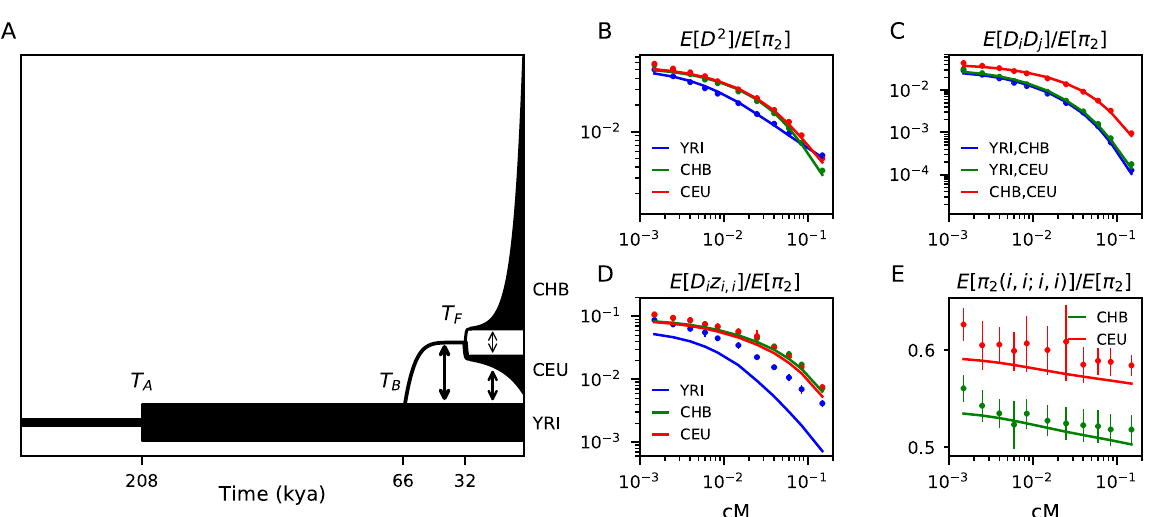
Fig 3. Standard out-of-Africa model underestimates LD among low frequency variants. (A) We fit the 13-parameter Gutenkunst et al . model to statistics in the two-locus, multi-population Hill-Robertson system. The remaining 35 statistics from the Hill-Robertson basis used in the fit are shown in Fig A7 in S1 Appendix, and residuals are shown in Fig A8 in S1 Appendix. Best fit values for labeled parameters are given in Table 1. Most statistics were accurately predicted by this model, including (B) the decays of E ½ D 2 � in each population, (C) the decay of the covariance of D between populations, and (E) the joint heterozygosity E ½ p model, and we were unable to find a three-population model that recovered these observed statistics, including with additional periods of growth, recent admixture between modern human populations, or substructure within modern populations. Error bars represent bootstrapped 95% confidence intervals on the statistic estimate.